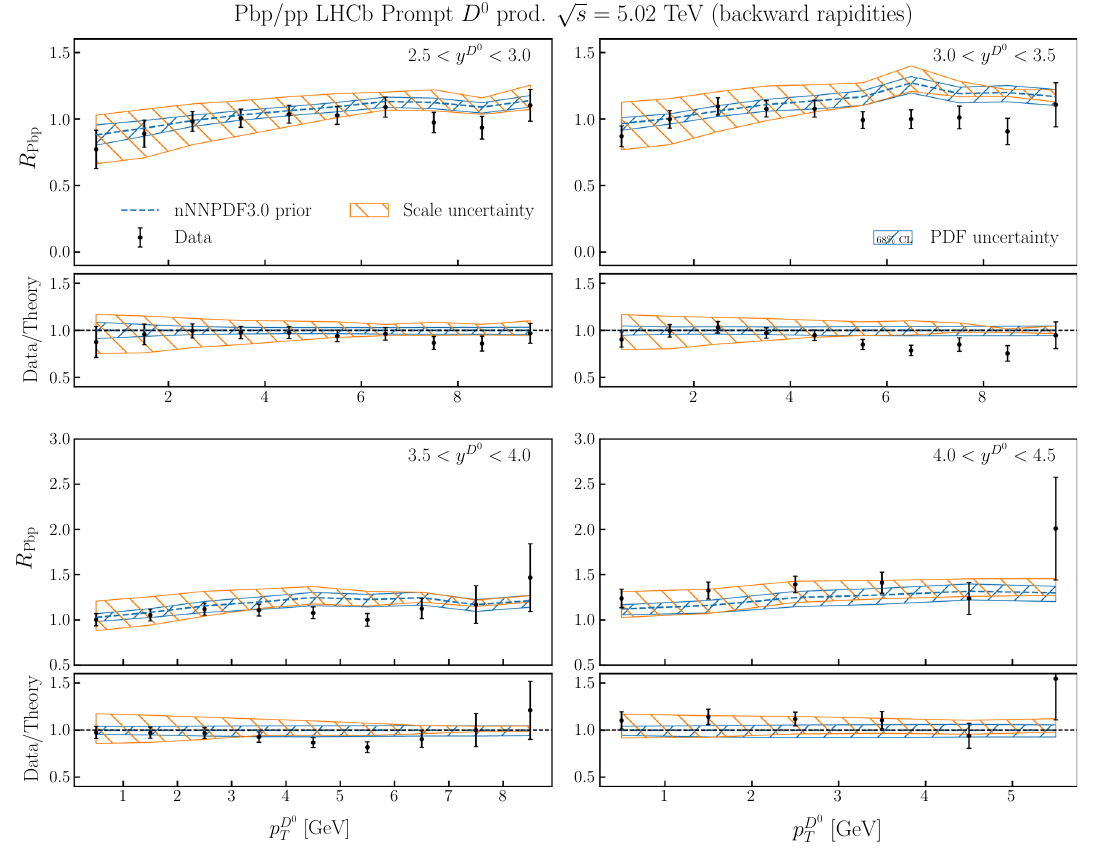
Fig. 8 Same as Fig. 7, now comparing the theory predictions based on the nNNPDF3.0 prior fit with the backward rapidity bins of the LHCb measurement of D 0 -meson production in Pbp collisions. While the predictions are consistent with the LHCb data, uncertainties due to